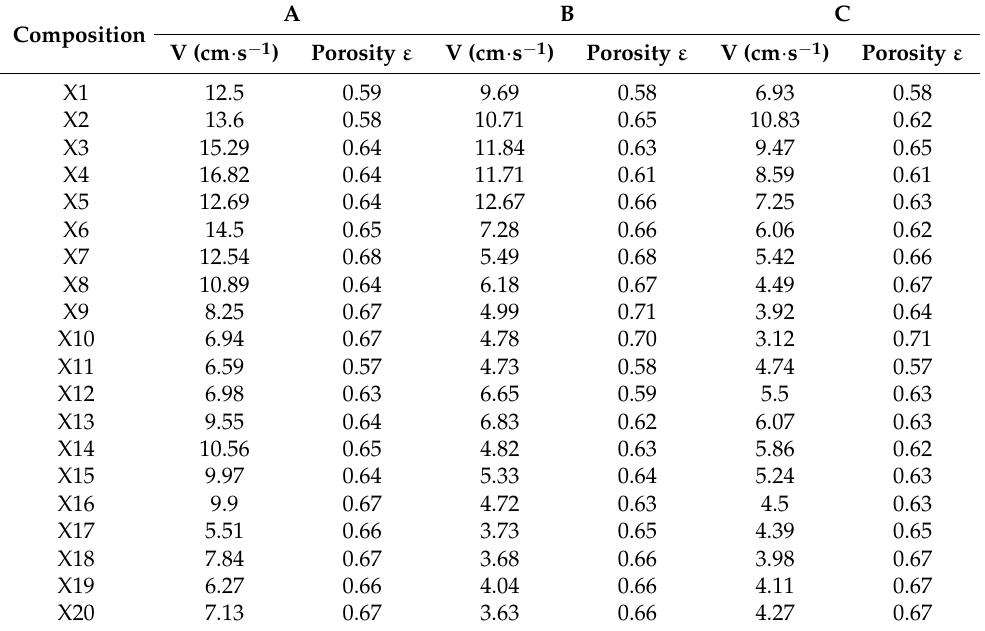
Table 4. Measured ternary compositions burning velocities and associated porosities.